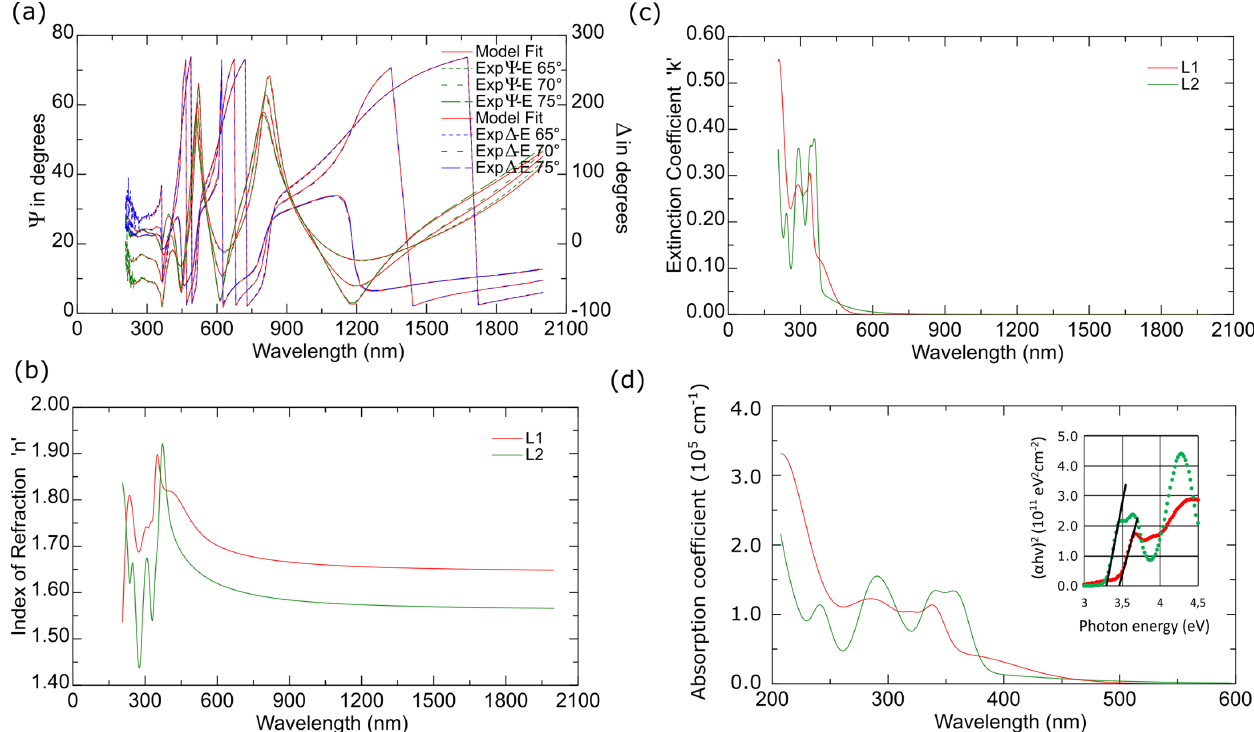
Figure 17. ( a ) Experimental and calculated Ψ and Δ azimuths for the L1 sample; ( b ) The refractive index ( n ); ( c ) the extinction coefficient ( k ); ( d ) the absorption coefficient of evaporated L1 and L2 layers (inset: the Tauc plot).